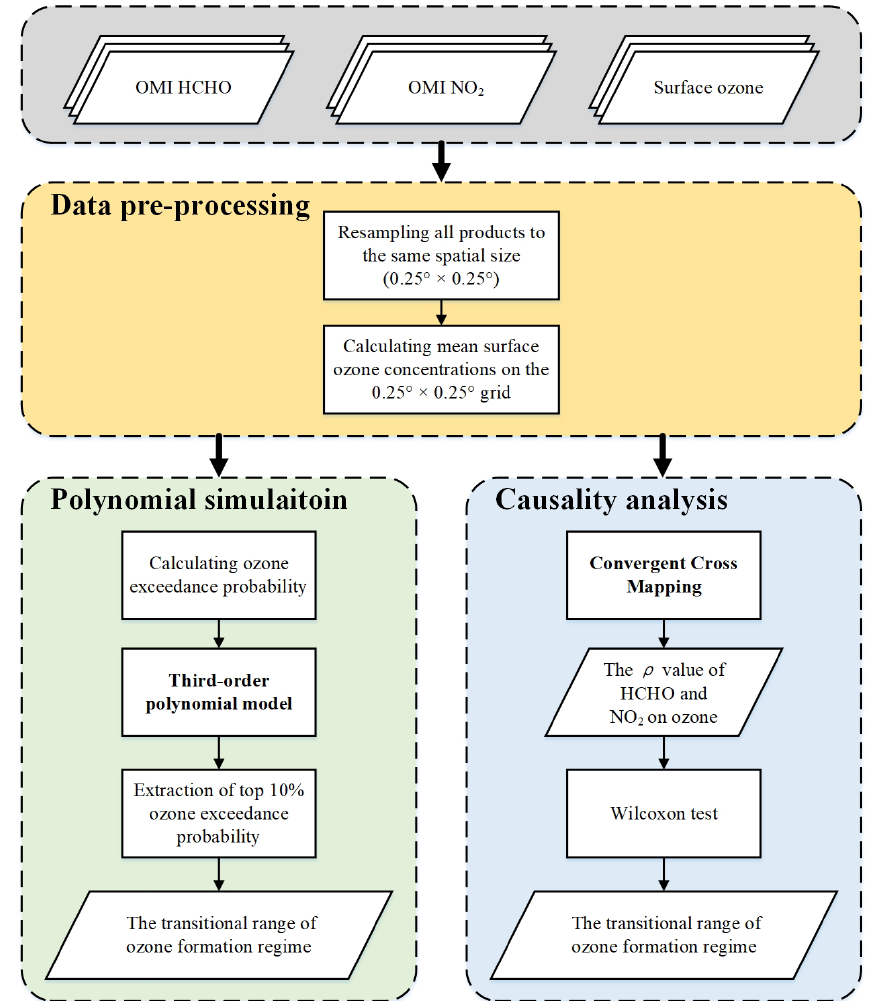
Figure 2. The workflow of the polynomial simulation and the causality